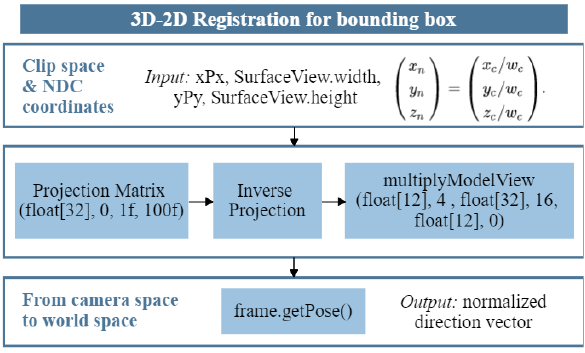
Figure 2: World coordinate frame ray computation for a screen point.